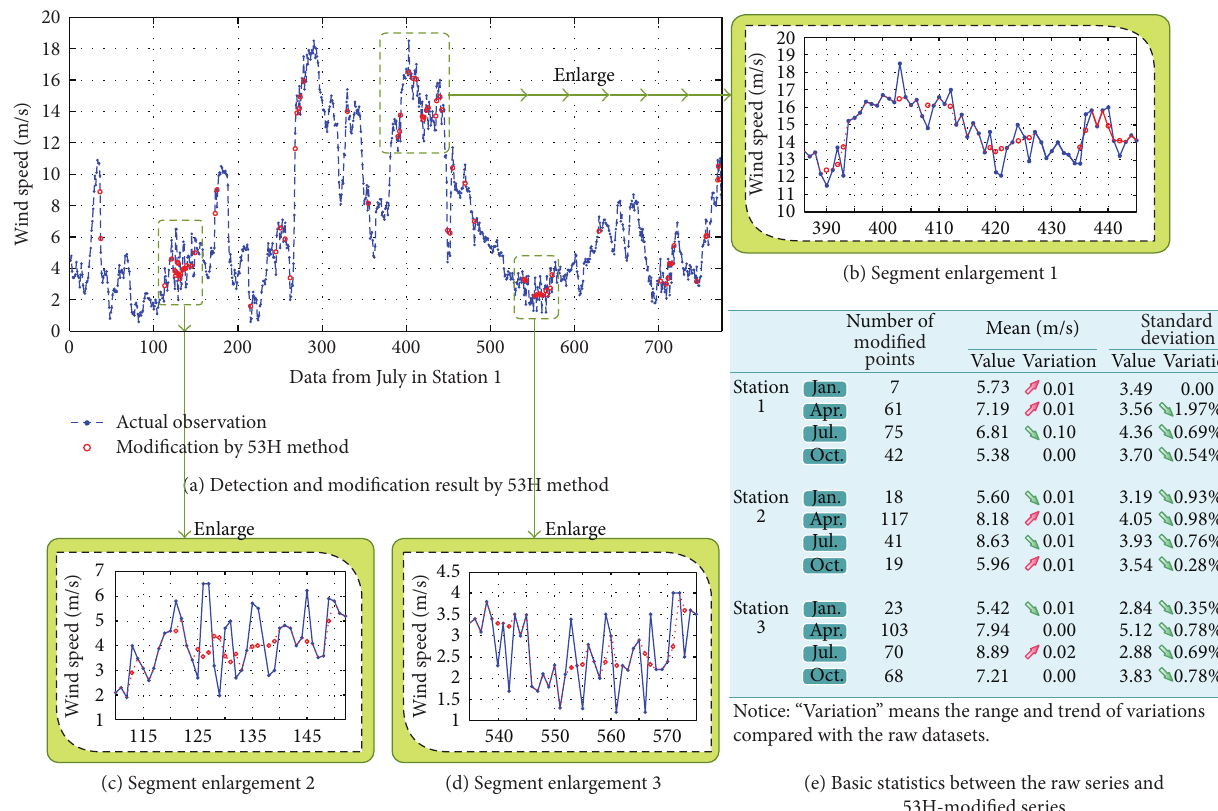
Figure 4: Data detection and modification by the 53H method, selected from July 2011 at Station